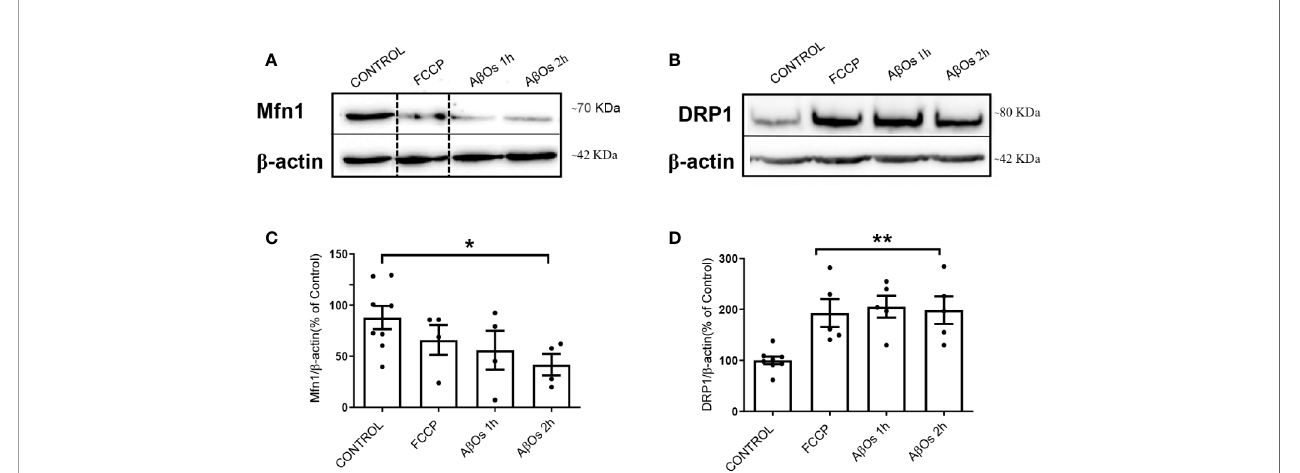
FIGURE 2 | Acute effects of A b Os on total levels of proteins that regulate mitochondrial dynamics. (A) Mfn1 and (B) DRP1 western blot of lysates from PC12 cells treated with FCCP (10 m M, 2 h) and A b Os (0.5 m M, 1 and 2 h). A dotted line on the western blot indicates different regions of the same gel. (C, D) Quanti fi cation of Mfn1 and DRP1 levels normalized to beta actin. Data are represented as mean ± SEM. *p < 0.05, **p < 0.01 compared between the control group. One-way ANOVA with the Dunnett's multiple comparisons test was used for all statistical analyses. Mfn1, mitofusin 1; DRP1, dynamin-related protein 1. (n = 4 – 5 for each group) (original gel blot are provided on Supplementary Figure 2 ).